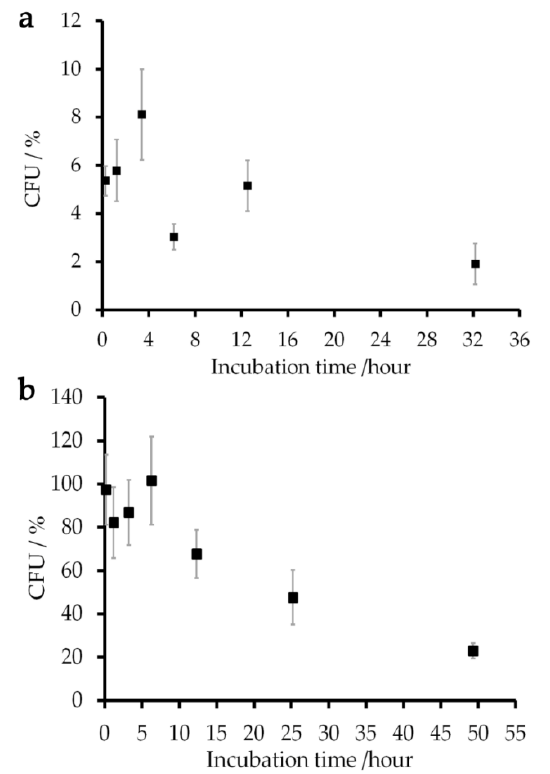
Figure 5. Percentages of CFU (colony-forming unit) of E. coli cells incubated in ( a ) 149 mM aqua Gd 3+ and ( b ) 150 mM Gd-DOTA solutions relative to that of the sample incubated in a 150 mM NaCl solution are shown by closed squares. The error bars give the standard deviations of the results of two independent samples.